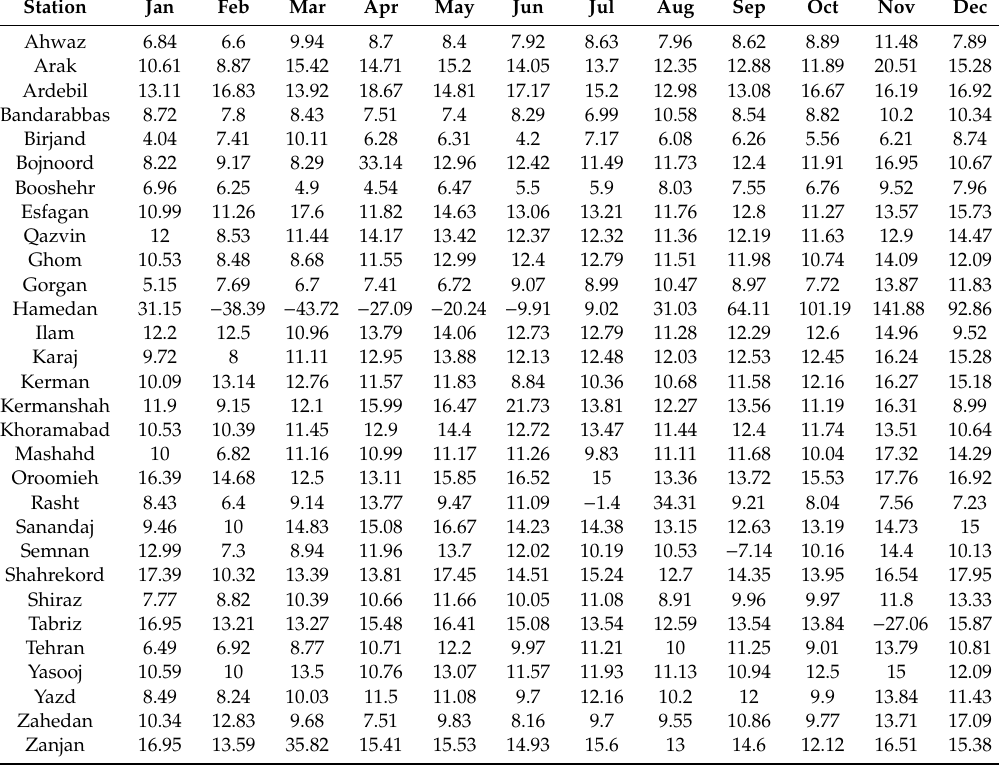
Table 8. Change percentages of the ET 0 predicted for the period from 2080 to 2113 under the A2 scenario.